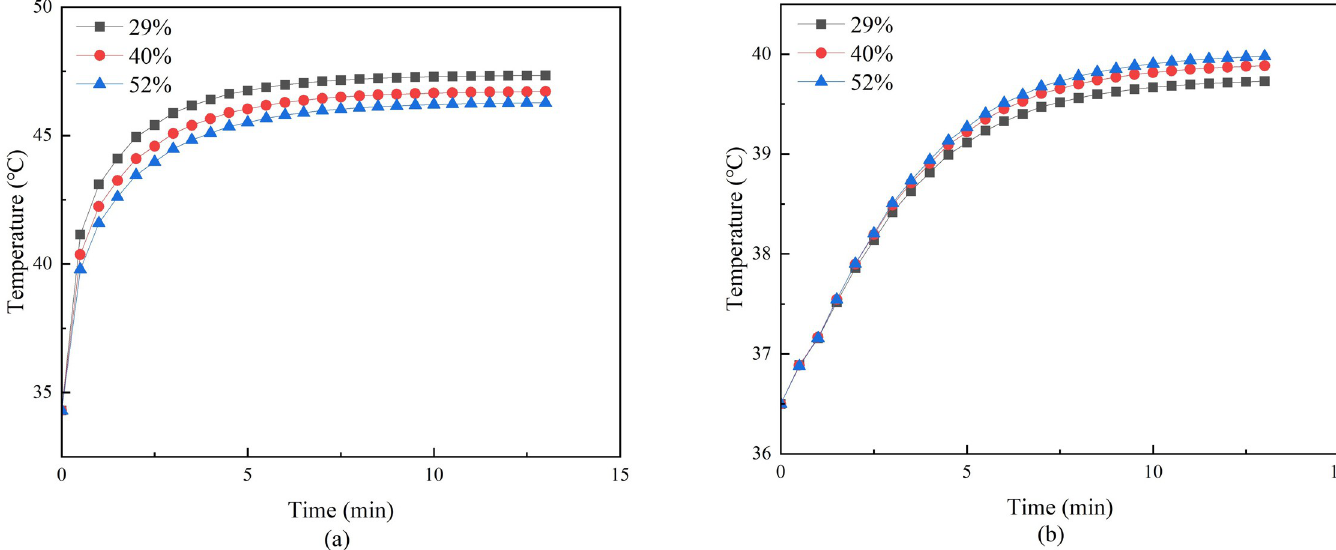
Fig 11. (a) Temperature curves of moxibustion points with different skin moisture content. (b) Temperature curve at 5mm under moxibustion point with different skin moisture content.